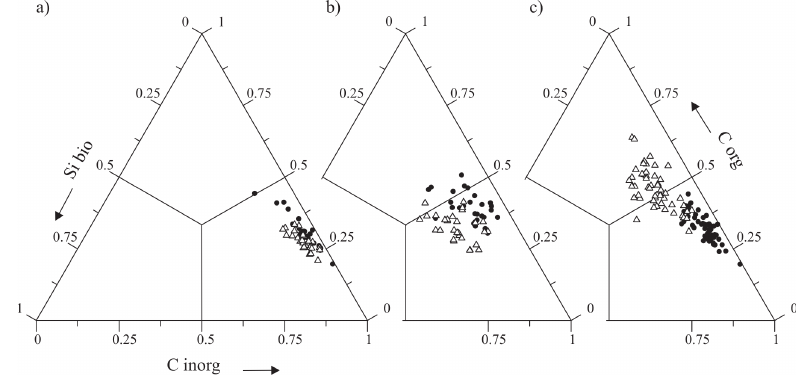
Fig. 8. Correlations of essential biochemical elements organic carbon, inorganic carbon, and biogenic silica, expressed in molar units during (a) the main DSWC event, from January to March 2006, (b) from April to middle July 2006 and (c) the remaining period. Samples from the upper and middle canyon stations are plotted in black dots and samples from the lower canyon, canyon mouth and open slope stations in white up